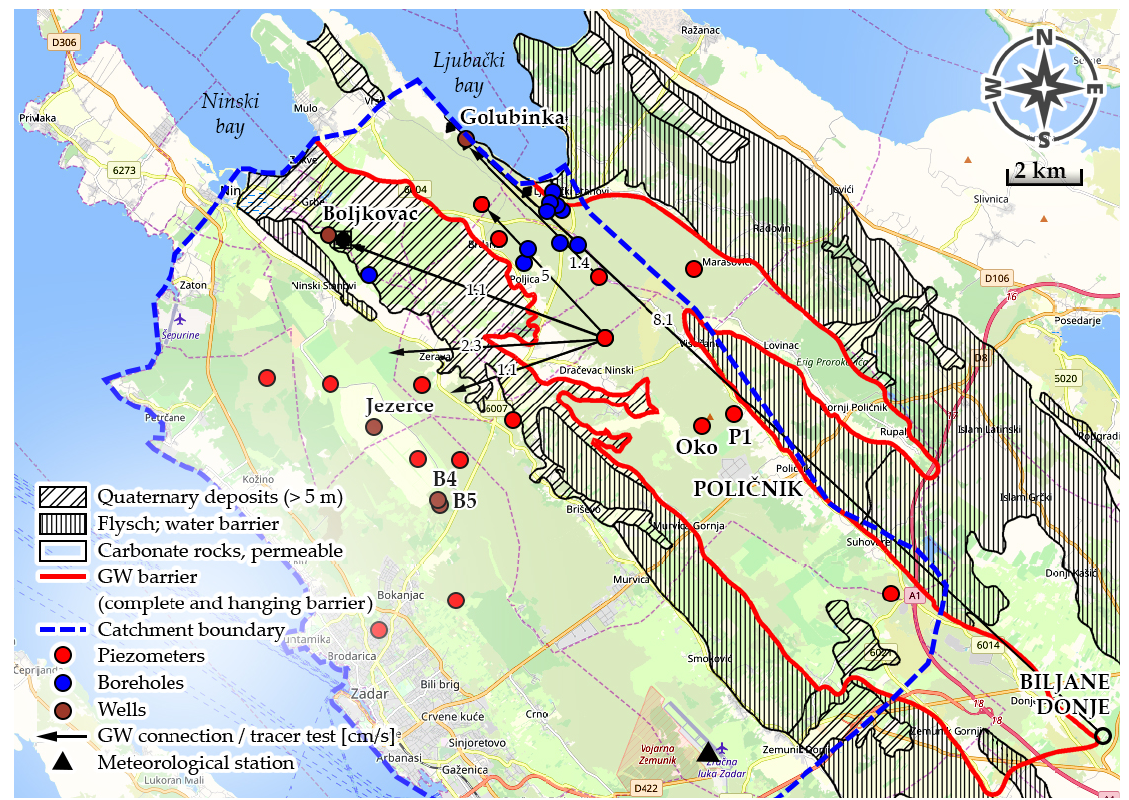
Figure 1. Schematic hydrogeological map of the Bokanjac-Poliˇcnik catchment area with the locations of boreholes, piezometers, wells and groundwater